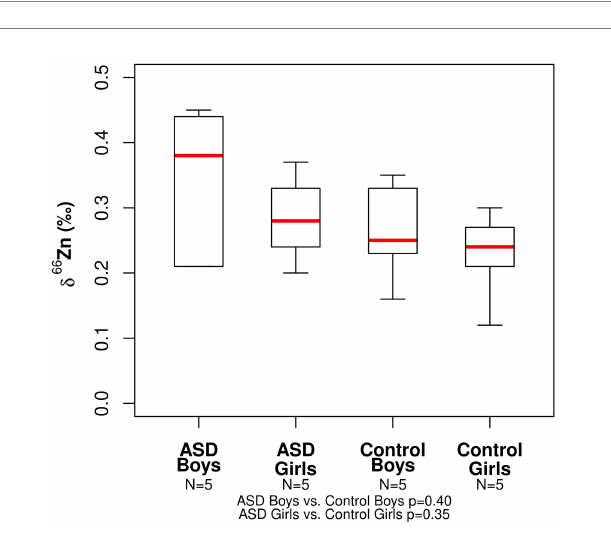
FIGURE 2 Boxplot for the Zn isotopic composition expressed as δ 66 Zn (‰) of bulk serum for the ASD and control populations.